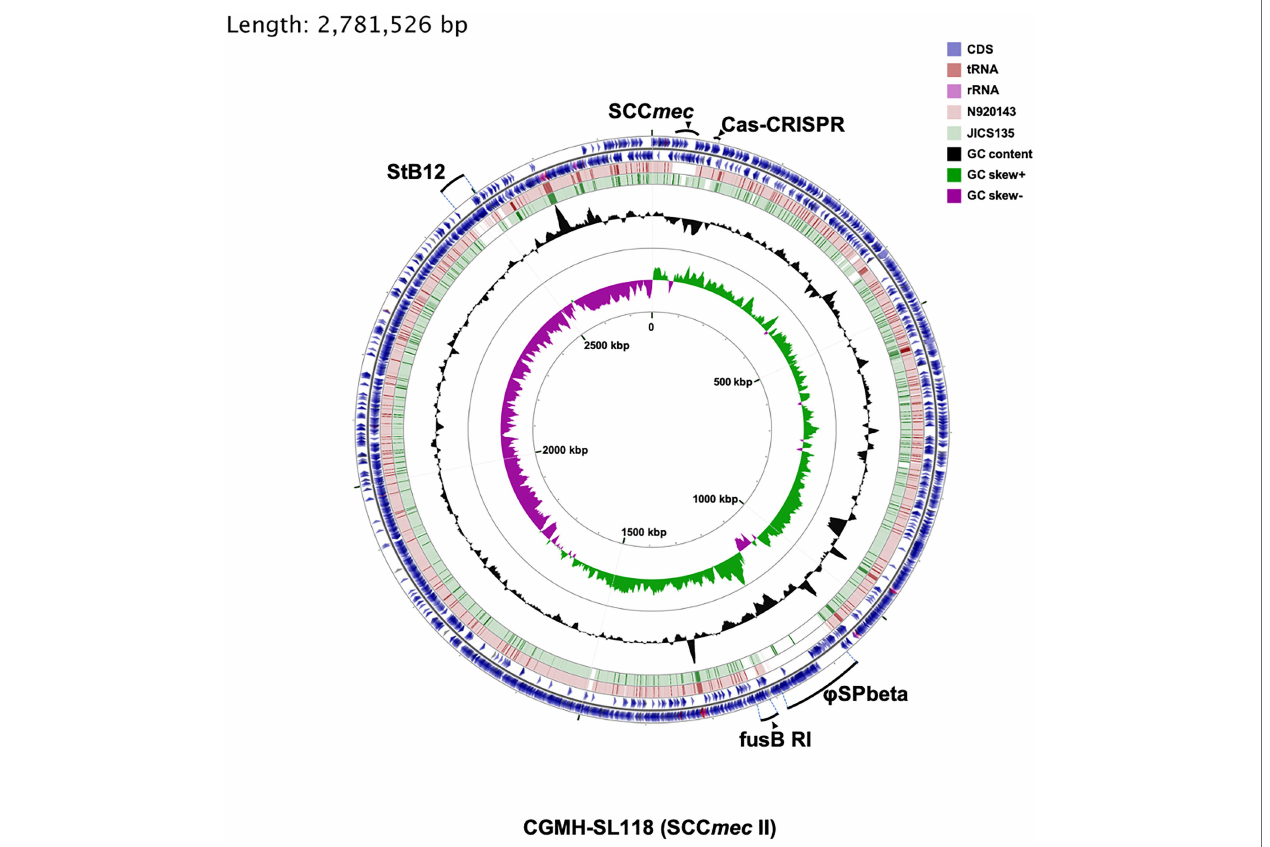
FIGURE 1 | Comparative genomic analysis of three Staphylococcus lugdunensis strains. Six rings for the circular diagram (inner to outer): GC skew of the CGMH- SL118, GC content of the CGMH-SL118, green ring representing the genome of JICS135, pink ring representing the genome of N920143, and two of the outer blue rings representing two coding strands (forward and reverse) of CGMH-SL118. On these two outer blue circles, three colors represent different gene types: blue represents coding sequence, shallow pink represents tRNA, and deep pink represent rRNA. mobile genetic elements (MGEs; prophage; StB12 and phi-SPbeta, SCC mec , fusB -resistant island) and CRISPR-Cas regions were labeled with bold